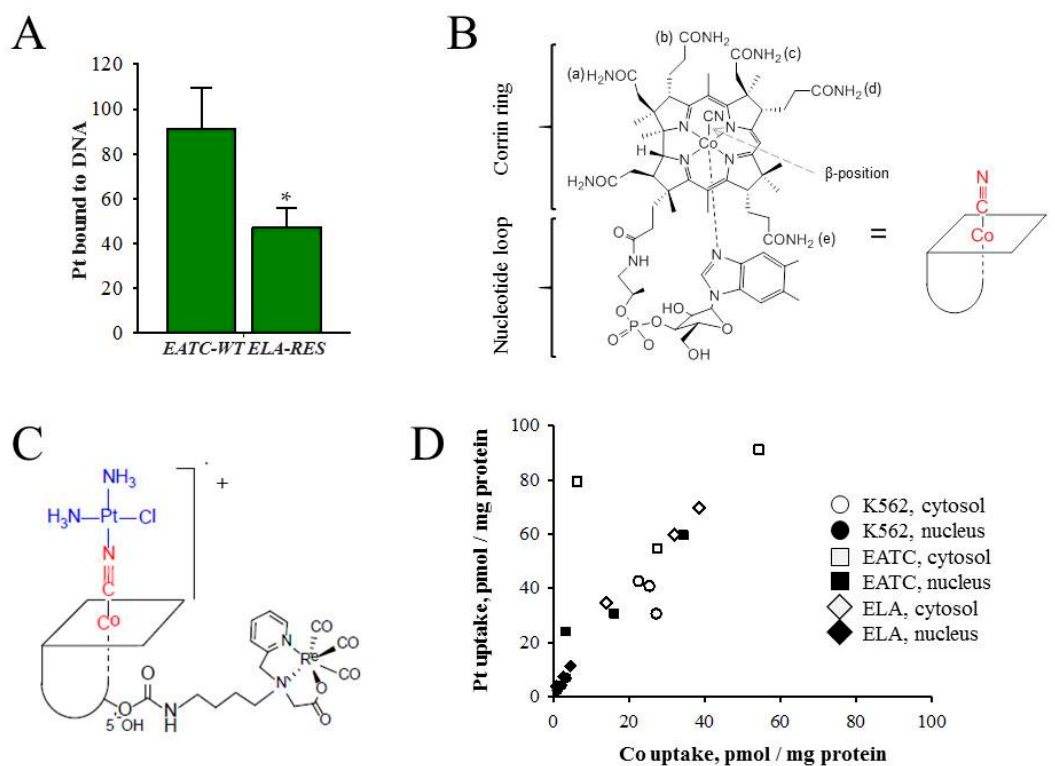
Figure 3. Vitamin B12 assisted cisplatin accumulation. ( A ) DNA, purified from non-adherent, cisplatin-sensitive Ehrlich cells (EATC-WT) and adherent, cisplatin-resistant Ehrlich cells (ELA-RES) following 18 h exposure to 10 µ M cisplatin, was quantified and the DNA-bound cisplatin was estimated by ICP-MS. Pt content is given relative to the DNA content (pg/ng DNA). * DNA-bound cisplatin in ELA-RES significantly lower compared to EATC-WT (* p < 0.05). Adapted from [55]; ( B ) Vitamin B12; ( C ) [{Re}-{Co}-CN-{ cis -PtCl(NH 3 ) 2 }] + ; and ( D ) Correlation between Pt (drug) and B12 (Co) uptake in the cytosolic and nuclear compartments in human immortalized myelogenous leukemia (K562), EATC, and ELA cells. Panels ( B – D ) reproduced with permission from [54].